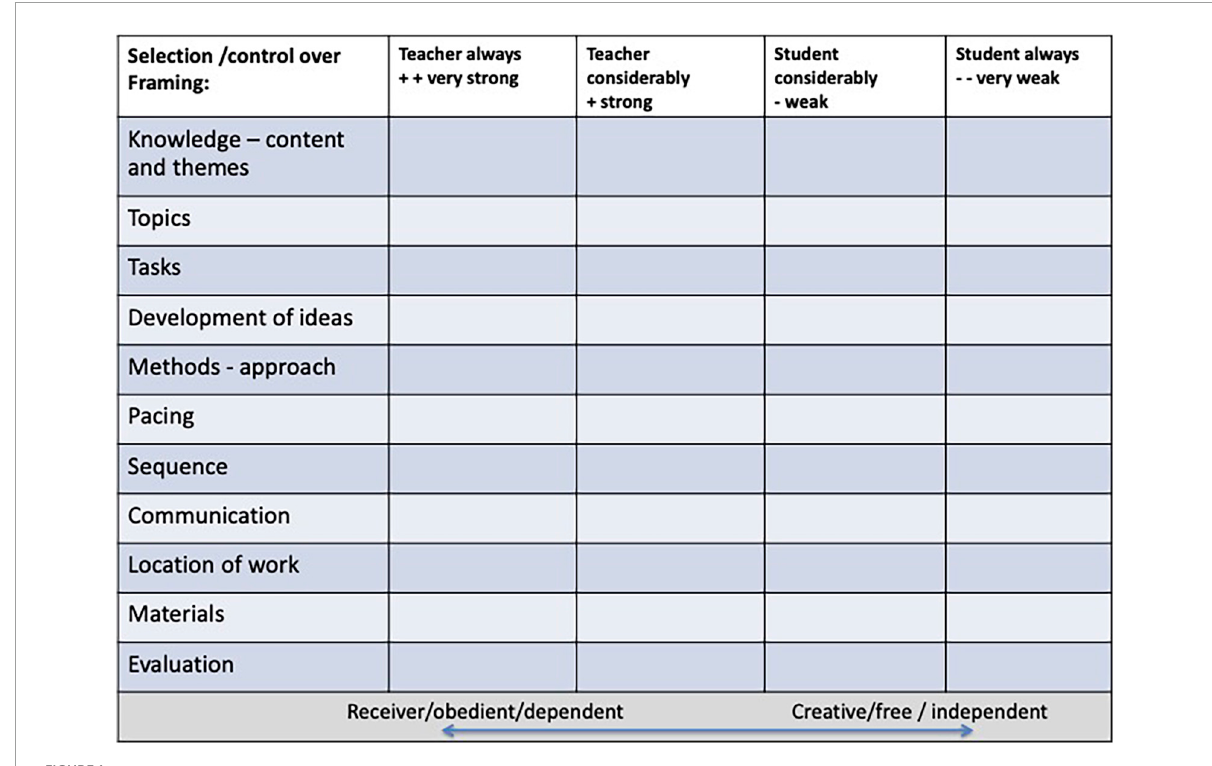
FIGURE1 The framing model as an analytical tool. Who is in control (Developed from Jónsdóttir, 2011).